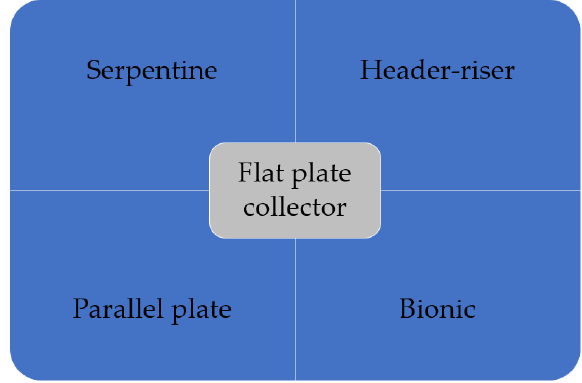
Figure 1. The major types of FPSCs.